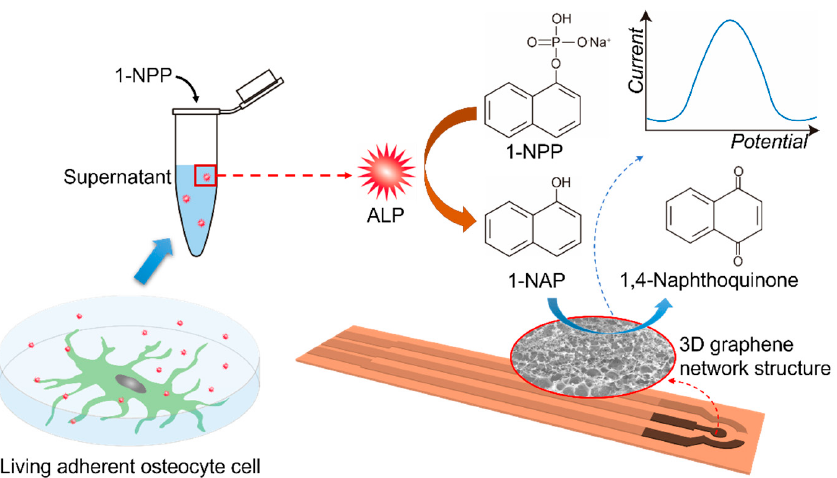
Figure 1. Detecting ALP secretion activity of living adherent osteocyte cells using supernatant by a 3DGNs modified SPE-based sensor.